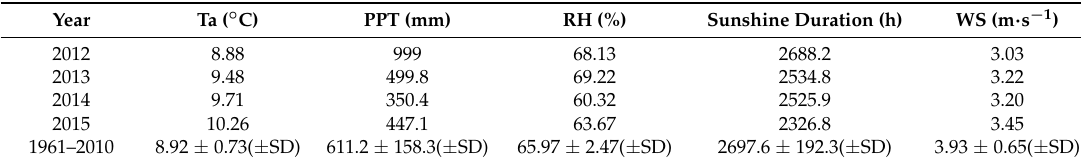
Figure 4. Comparison of the meteorological elements with the 50-year average (1960–2010). ( a ) Temperature; ( b ) Precipitation; ( c ) Wind speed; ( d ) Relative humidity; ( e ) Sunshine duration.